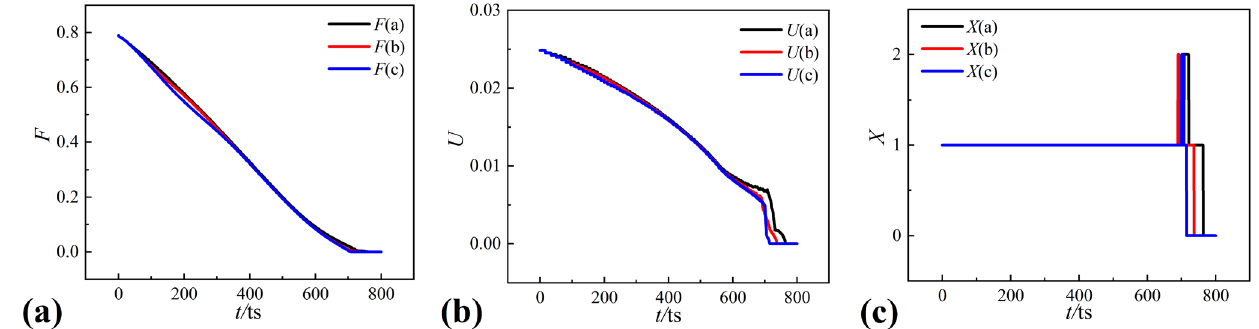
Figure 13. Morphological analysis of the collapsing bubble under the same fractal dimension: ( a ) fractional area F , ( b ) boundary length U , and ( c ) Euler characteristic X .